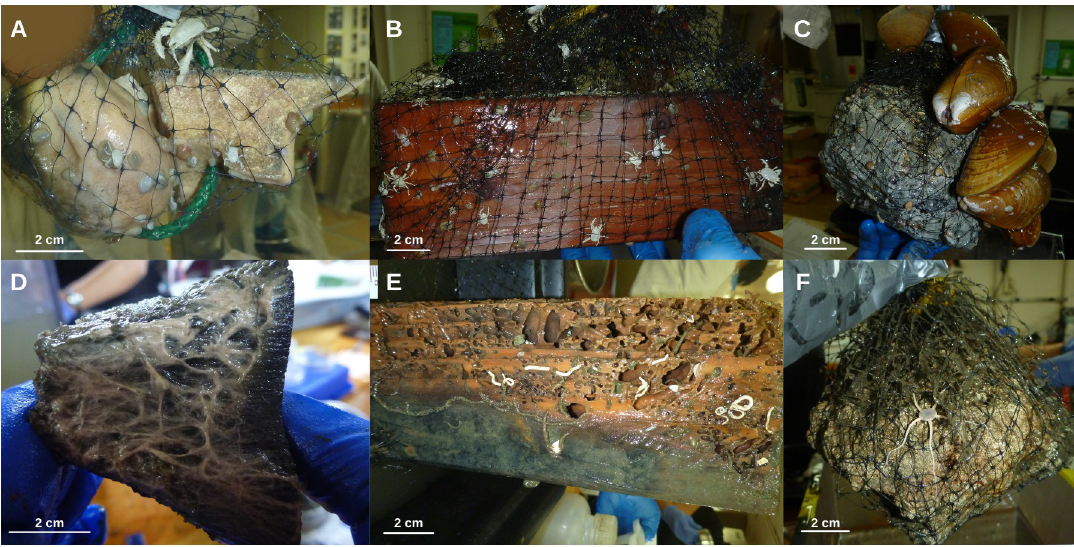
Fig 2. Photos of the experimental substrates upon recovery. Experimental bones, wood, and carbonate rocks were deployed for 7.4 years (2010–2017) at (A-C) active and (D-F) transition sites at Mound